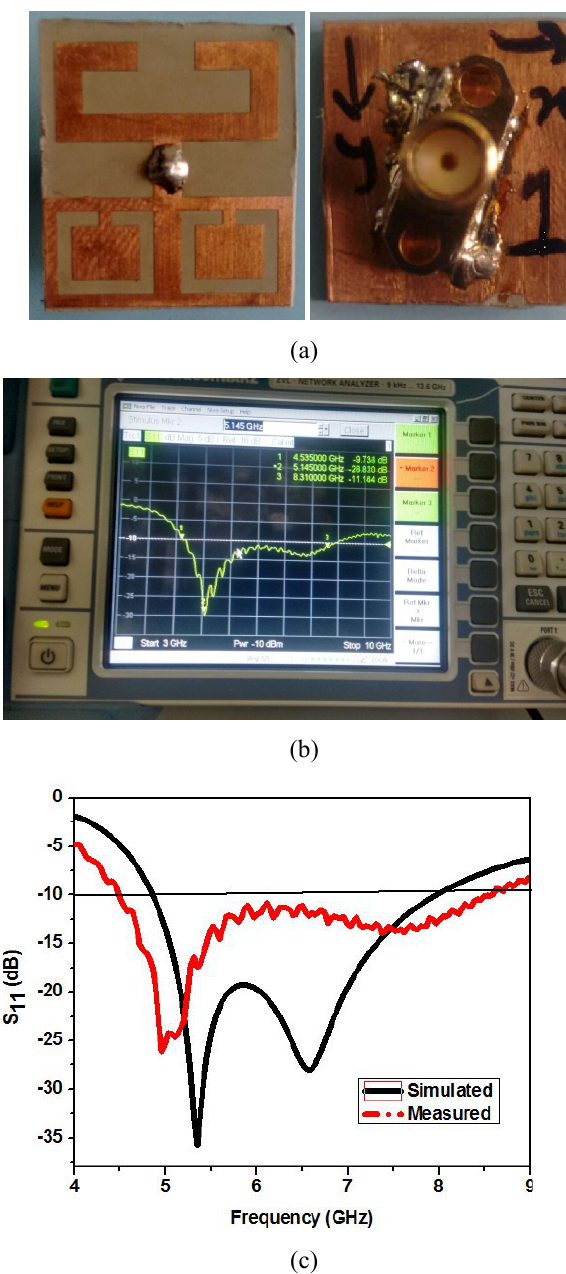
Figure 10. E- Plane normalized radiation pattern of the proposed design at (a) 5.3 and (b) 6.6